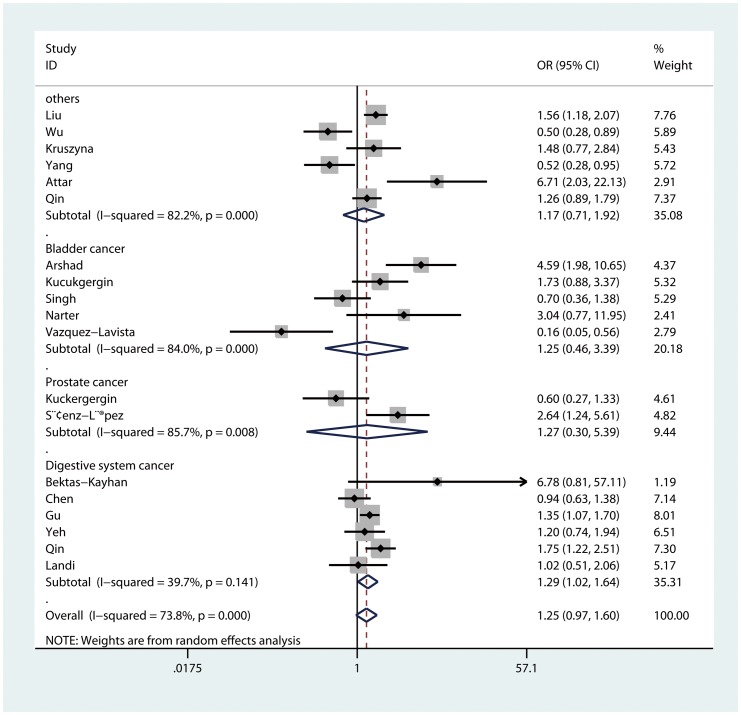
Forest plot of recessive model for overall comparison by cancer type (GG vs. AG/AA).